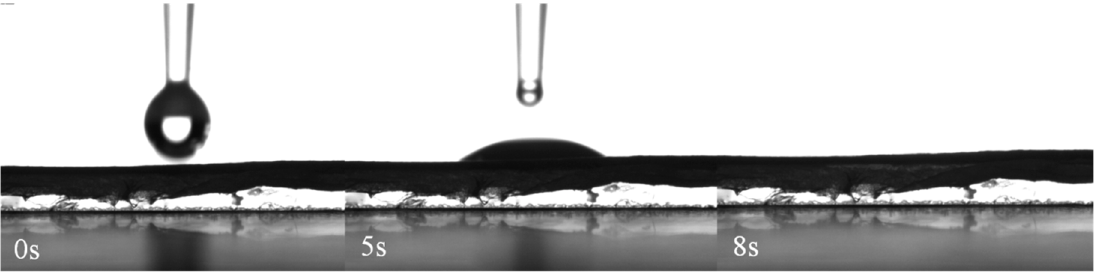
Figure 4. Frames from drop shape analysis of water on the ES nanofibers surface for PCL+ PEGSP2